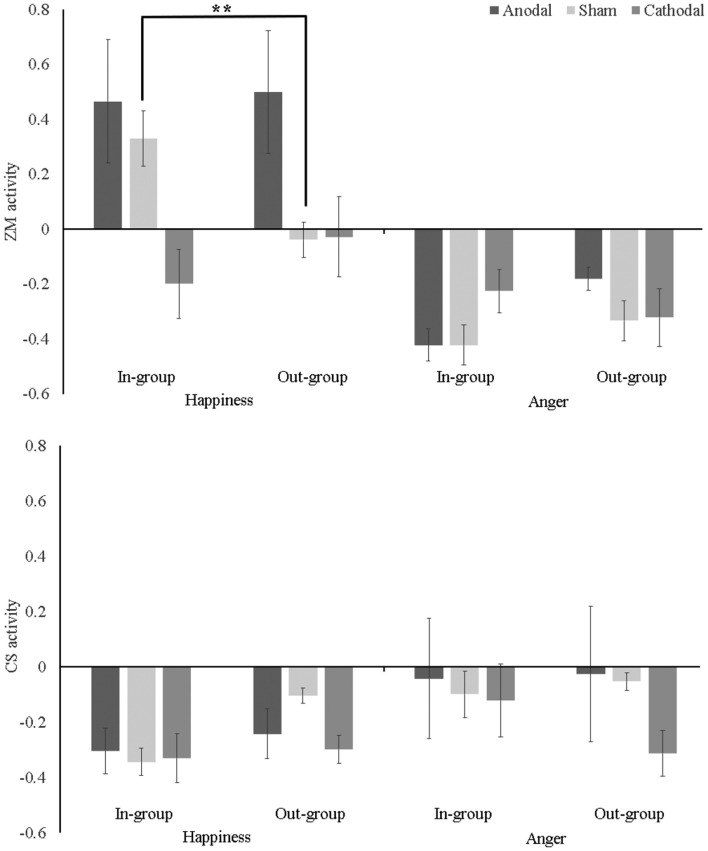
Mean zygomatic major (ZM; upper panel) and corrugator supercilii (CS; lower panel) activity (baseline-corrected) as a function of transcranial direct current stimulation (tDCS), Ethnic Group, and Emotion. Error bar indicates one SE. **p < 0.01.